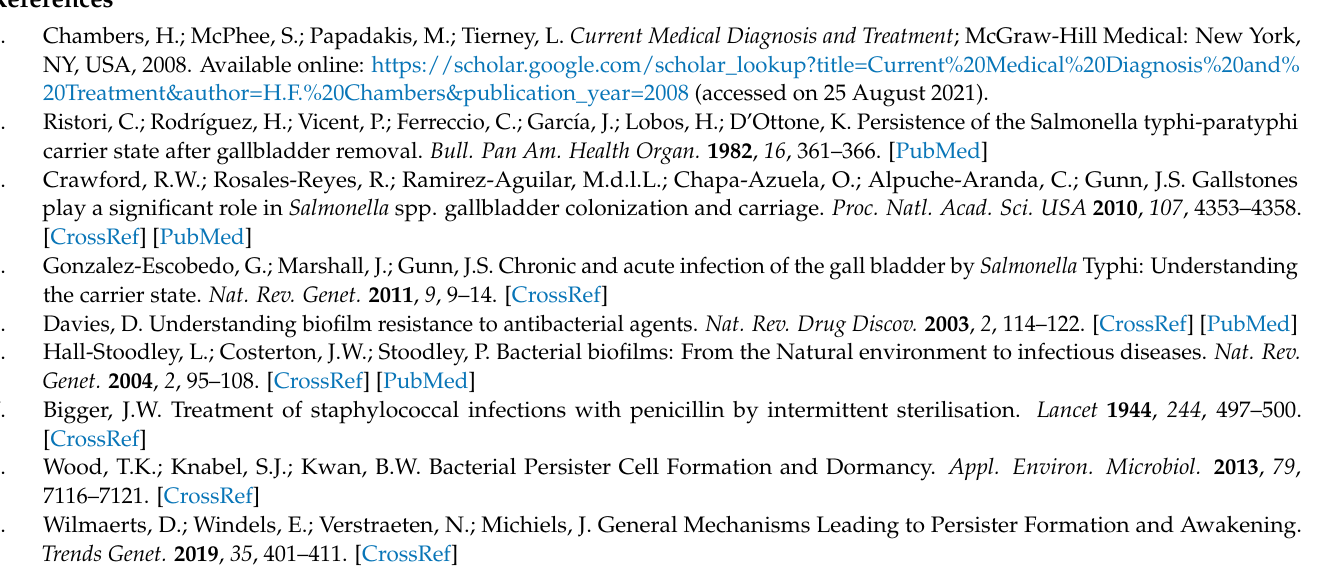
Table S2: Raw CFU